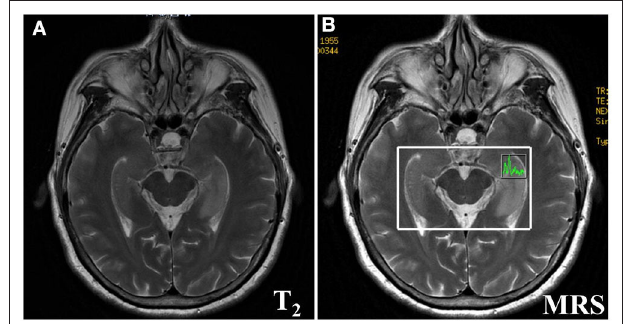
FIGURE 1 | Brain MRI (A) showed lesions in the left hippocampus. Brain Magnetic resonance spectrum (MRS) showed a bit increased slightly elevated Choline compound (Cho) and Cho/ Cr peak, the moderately decreased the N-acetyl aspartic acid (NAA) and NAA/Creatine ( Cr) peak (B) in the left hippocampus.